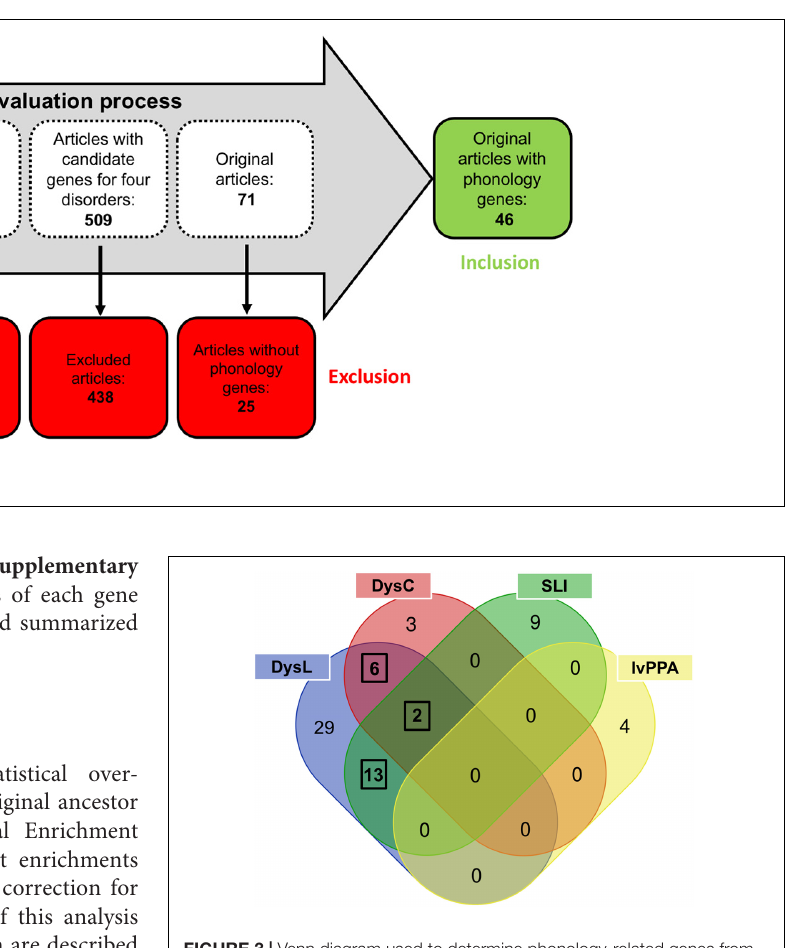
FIGURE 3 | Venn diagram used to determine phonology-related genes from candidate genes overlapping between language and/or learning disorders. The three black frames indicate overlaps of genes associated with at least two disorders. DysL, dyslexia; DysC, dyscalculia; SLI, specific language impairment; lvPPA, logopenic variant of primary progressive